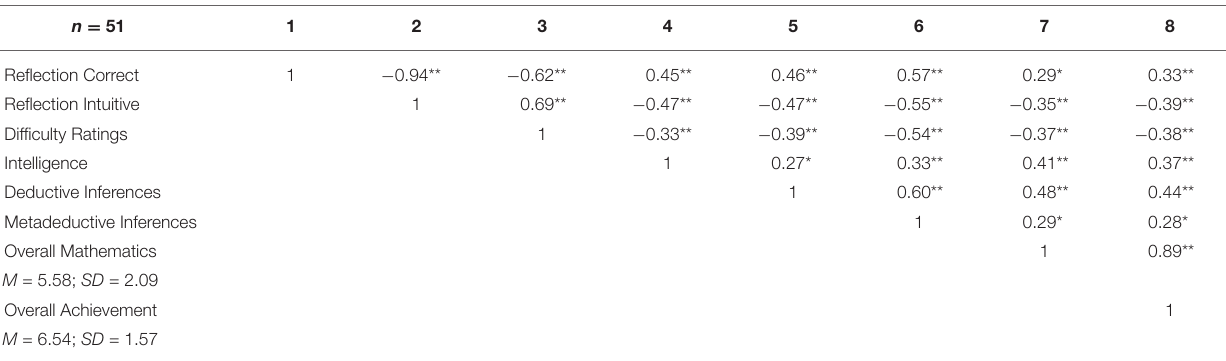
TABLE 3 | Pearson correlations between Cognitive Reflection Test (Correct and Intuitive responses, and Ratings of Difficulty), Intelligence (RPMT), Deductive and Metadeductive Inferences, and the two Academic Achievement measures. n = 51